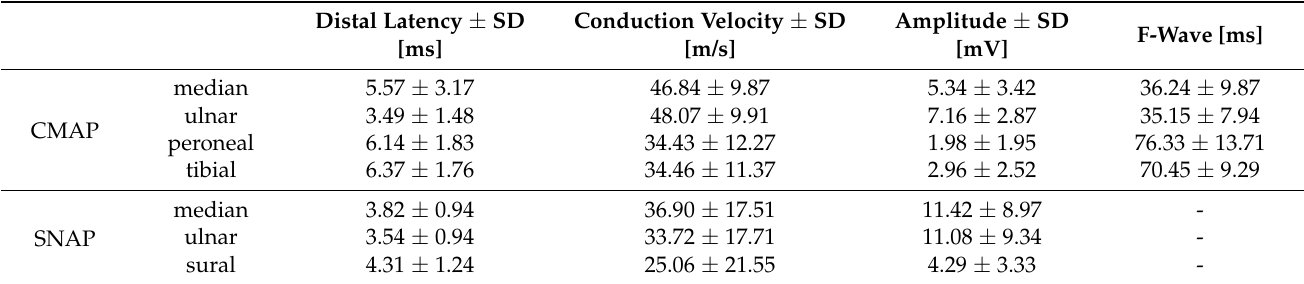
Table 1. Mean values of motor and sensory nerve conduction results in the study group.